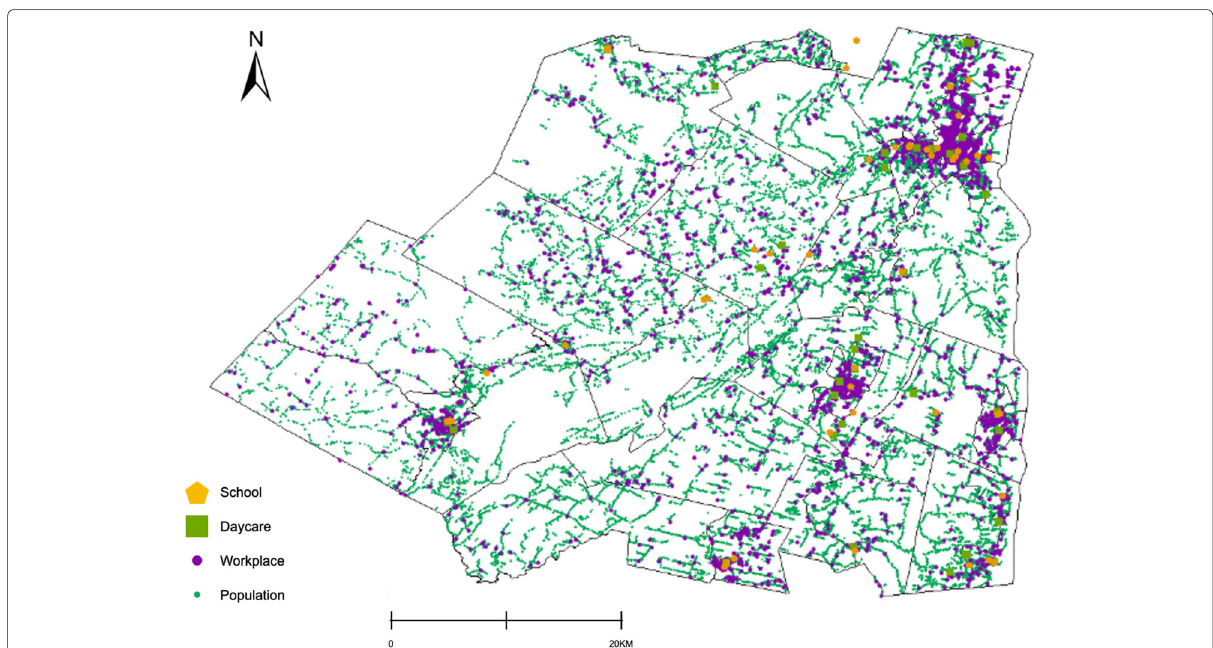
Fig. 16 Disease Model Study